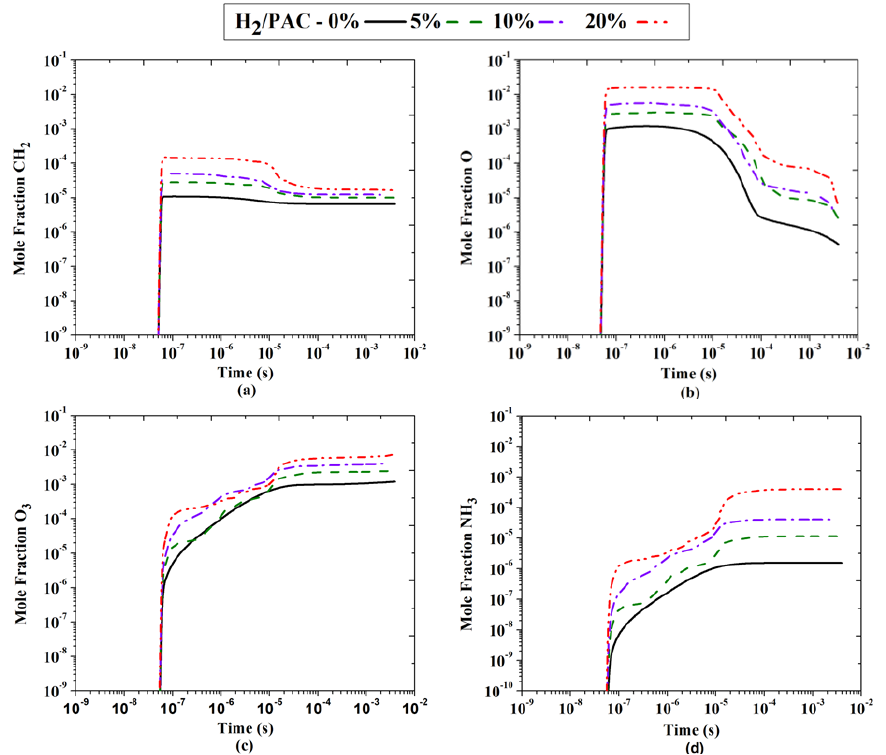
Figure 5. Temporal evolution of ( a ) CH 2 , ( b ) O, ( c ) O 3 , ( d ) NH 3 concentrations at different contents of H 2 in methane/air mixture using fixed plasma actuation conditions.